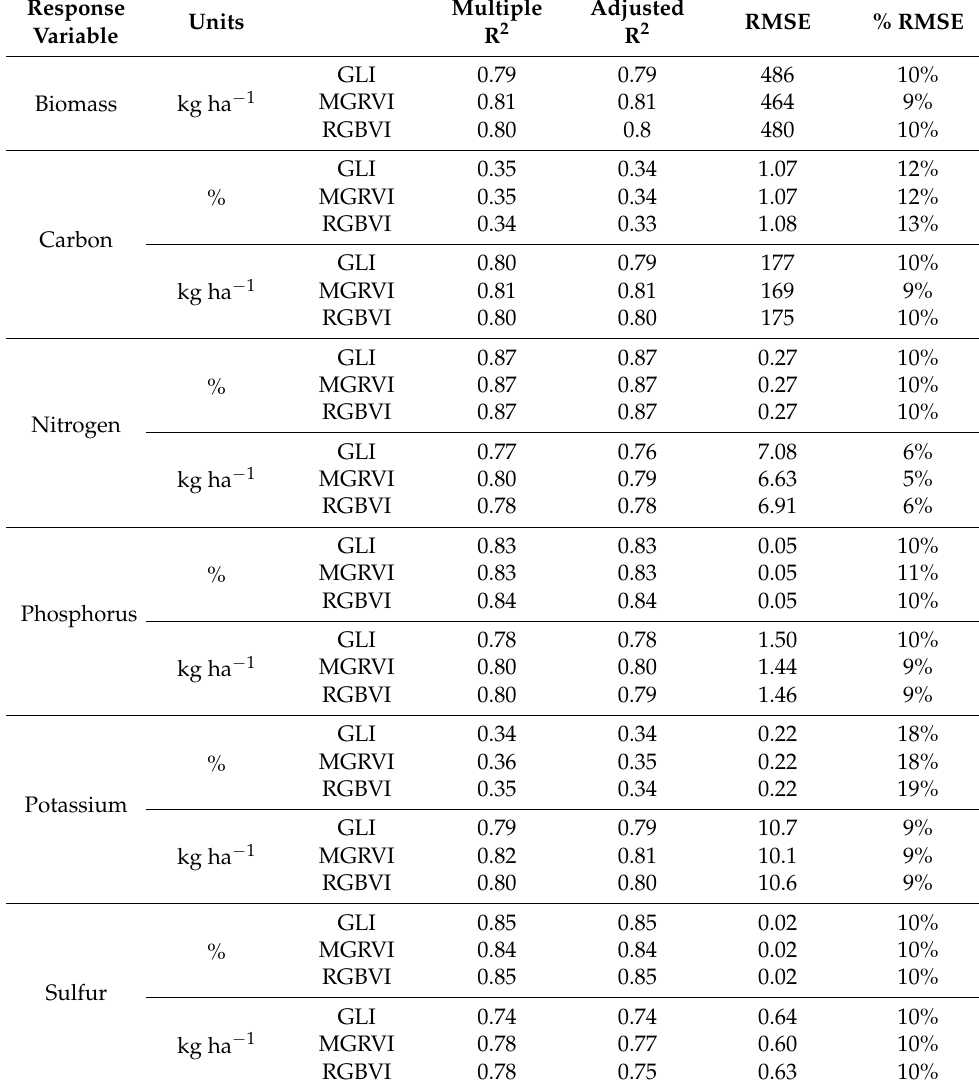
Table 10. Multiple R 2 , adjusted R 2 , root mean square error, and percent root mean square error values of the final fitted models for the response variables of cereal rye biomass, carbon, nitrogen, phosphorus, potassium, and